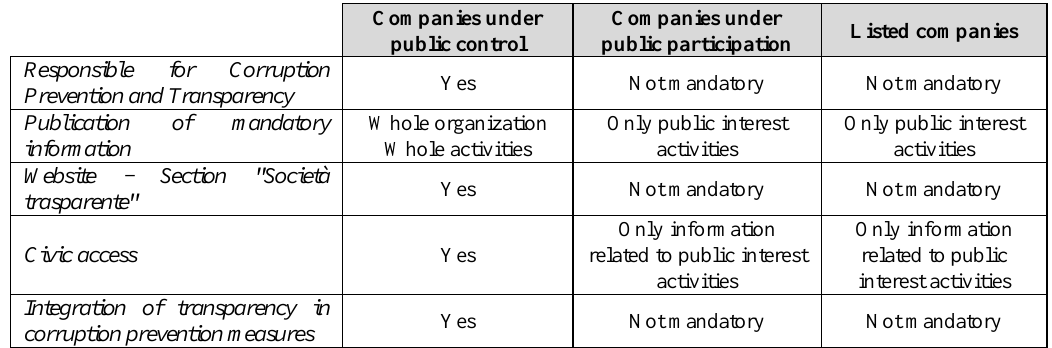
Table 4: Implementation of Transparency Measures in Different Types of